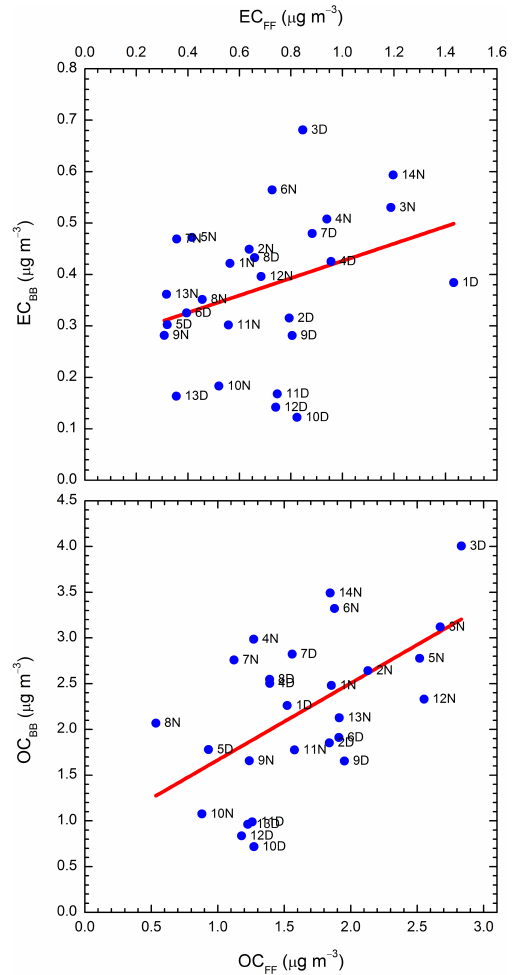
Figure 6. Scatter plots between apportioned atmospheric concentra- tions of OC BIO and OC FF , and of OC BIO and OC BB , for the PM 2 . 5 size fraction in central Budapest. The red lines represent a linear fit to the data. The order number of the samples together with daylight time (D) or night (N) periods is indicated by labels next to the data